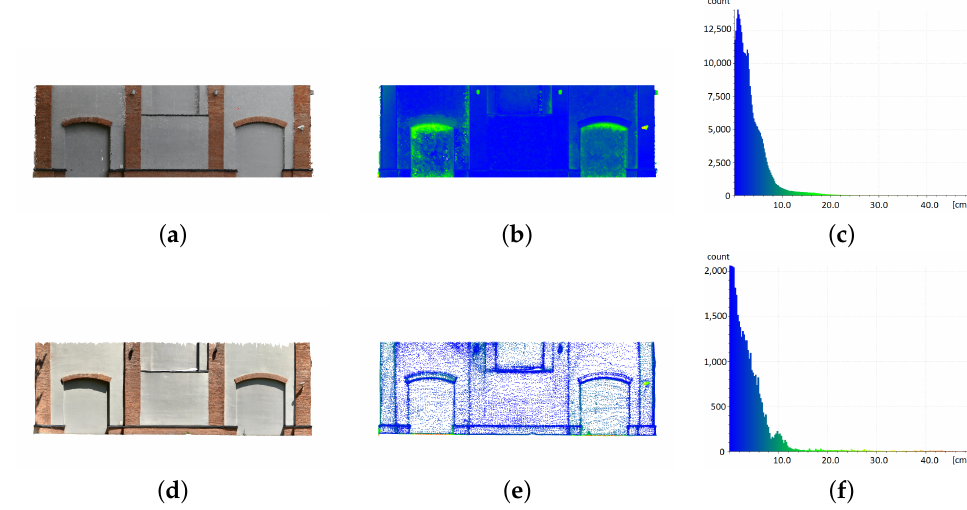
Figure 10. Comparison of statistical values for the building facade. Photogrammetry: ( a ) textured mesh, ( b ) point cloud, ( c ) histogram of distances to the model; iPad: ( d ) mesh, ( e ) point cloud, ( f ) histogram of distances to the model. Point clouds are coloured according to histogram data.